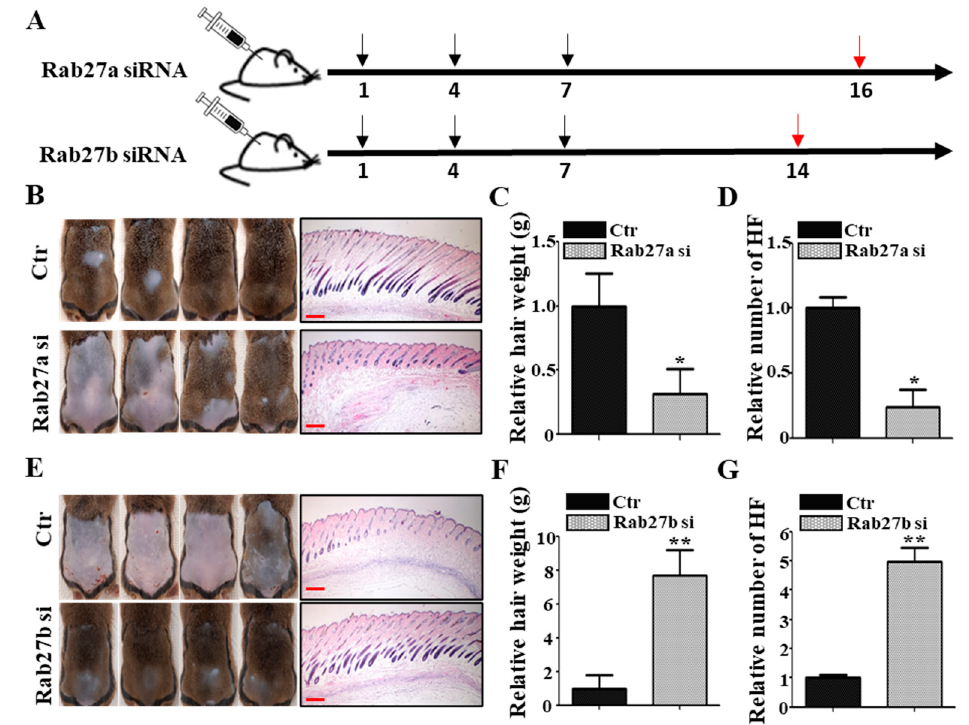
Figure 2. Rab27a and Rab27b have opposite effects in mice. ( A ) In vivo, Rab27a siRNA was injected into the mouse dorsal skin once every 3 days for a total of three times, and the hair and dorsal tissue of the mice were harvested after 16 days. Rab27b siRNA was injected into the mouse dorsal skin once every 3 days for a total of three times, and the hair and dorsal tissue were harvested after 14 days. ( B – D ) Knockdown of Rab27a inhibited telogen-to-anagen transition evidenced by hair weight and the number of hair follicles compared with the control. ( E – G ) In contrast, knockdown of Rab27b promoted telogen-to-anagen transition evidenced by hair weight and the number of hair follicles compared with the control. Ctr; control, si; siRNA. Black arrows indicate the day of siRNA injection. Red arrows indicate that samples were harvested that day. Scale bars indicate 200 µ m ( B ). * p < 0.05, ** p < 0.01, using Student’s t test. n = 4 per group. Three independent experiments were conducted. All error bars indicate